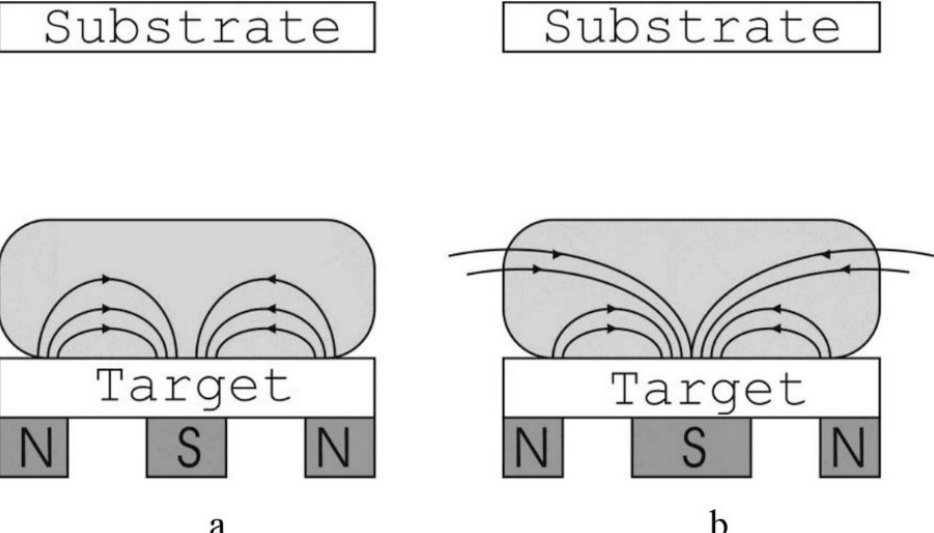
Figure 2. ( a ) Balanced MS and ( b ) unbalanced MS schematic diagrams [N: North pole, S: South pole]. Reproduced with permission from [22]. Copyright 2016, Elsevier.